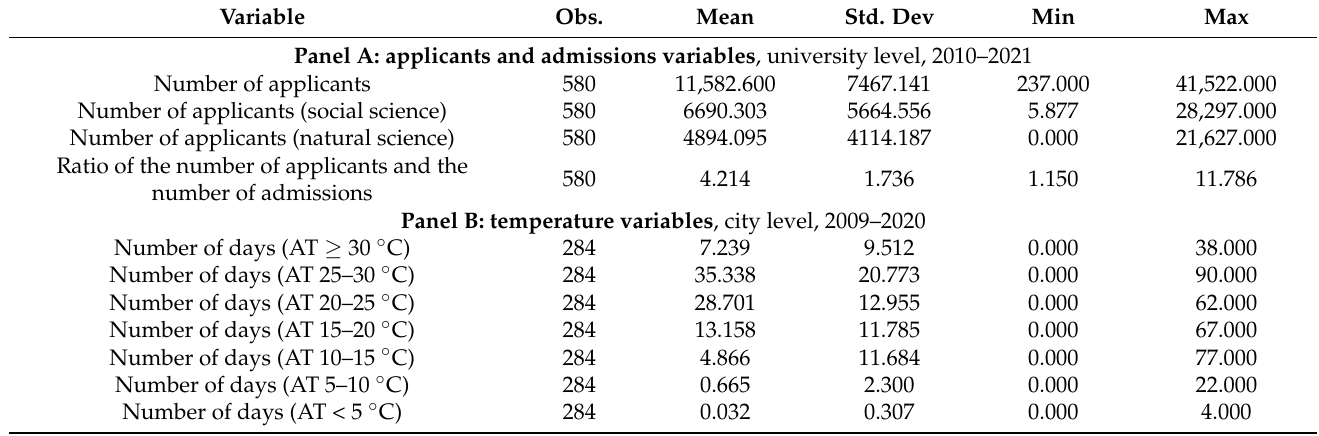
Table 1. Summary